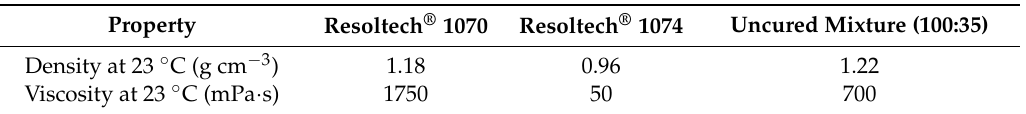
Table 2. Summary of some physical properties of the epoxy system based on Resoltech ® 1070 partially bio-based epoxy resin and Resoltech ® 1074 hardener.